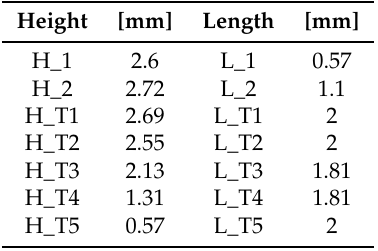
Table 1. Geometrical parameters of the